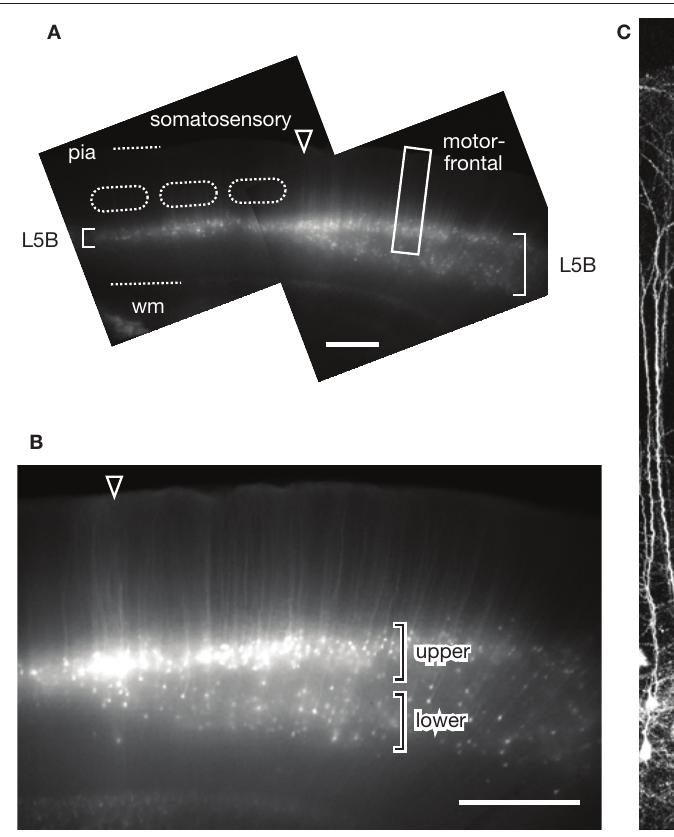
cortex. (C) High-resolution image of YFP-positive neurons in motor-frontal cortex [from another slice, location approximately as indicated by rectangular box in (A) ]. Neurons were imaged in vitro with 2-photon microscopy. (D) Examples of epifl uorescence images of slices with corresponding bright-fi eld